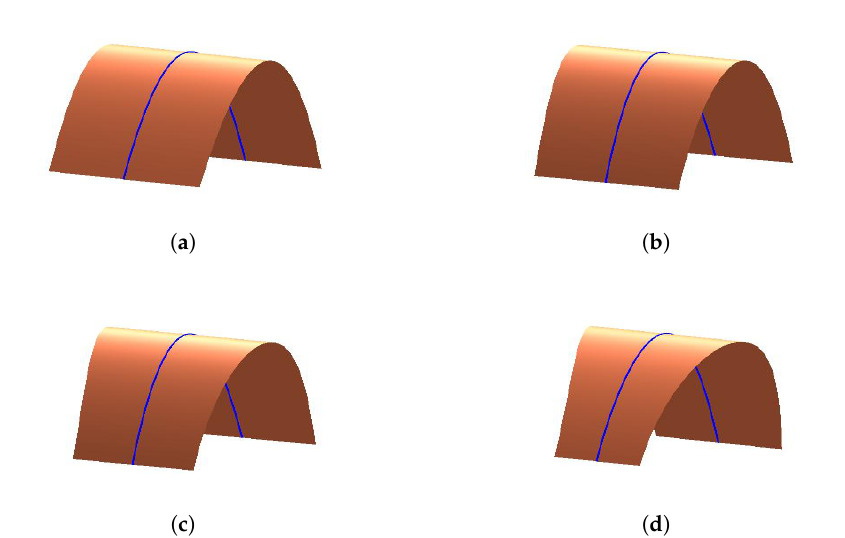
Figure 12. The effects of parameter α 2 on the developable surface through geodesic. ( a ) α 1 = π π , α 3 = π ; ( b ) α 1 = π 4 4